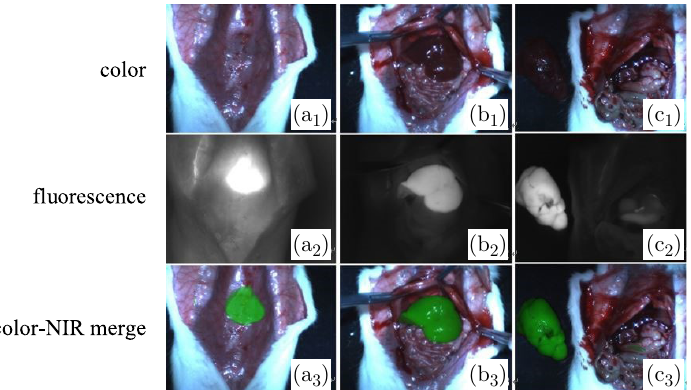
Fig. 5. SD rat abdominal image with the strongest liver °uorescence signal. a series: abdominal wall muscular complete; b series: open abdominal wall; c series: liver in vitro